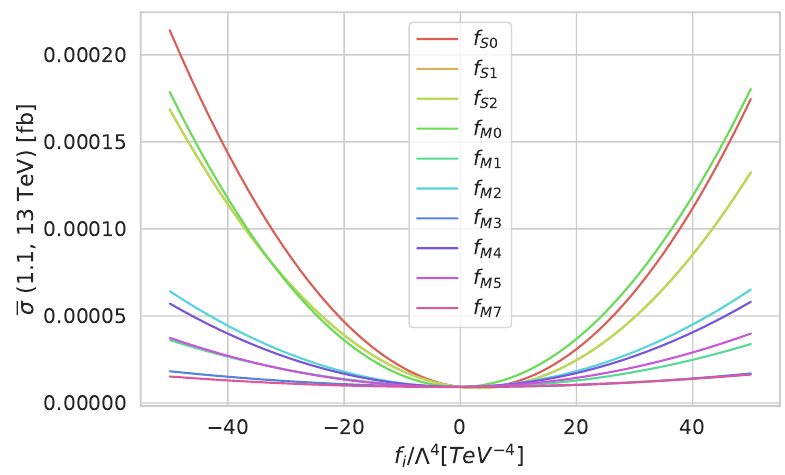
Figure 8 . Quadratic fits of σ [1.1 TeV, 13 TeV] for the ggZZH process varying the coefficients of different dimension-8